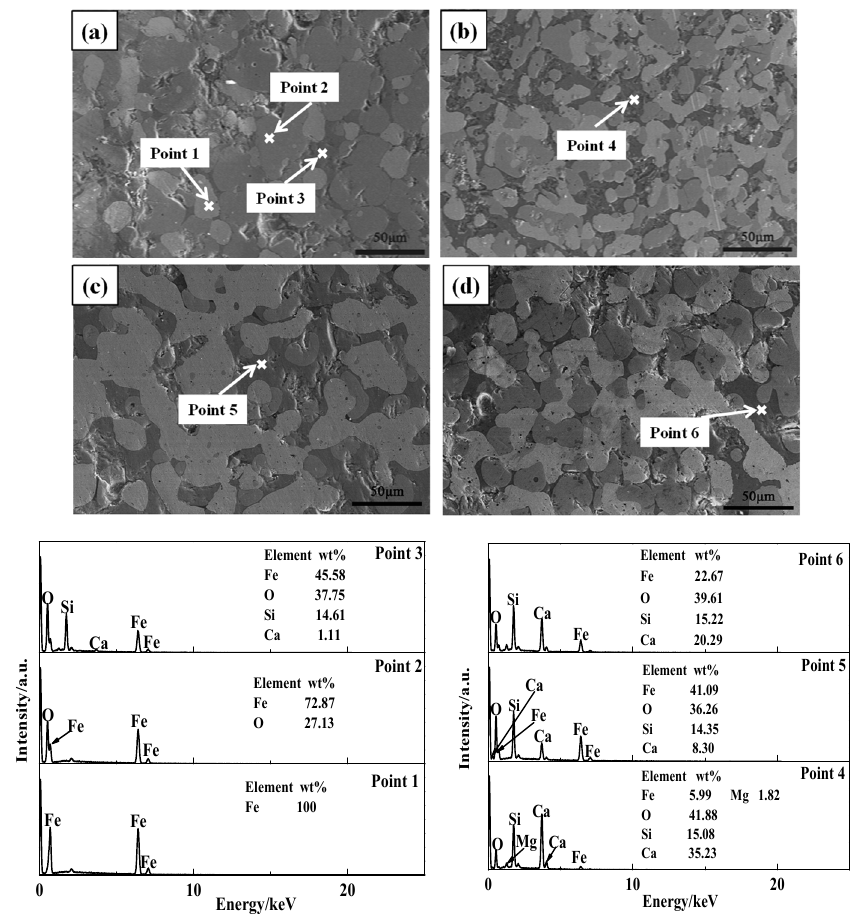
Figure 18. SEM images and EDS analysis of polished pellets at melting temperature with different burden composition: ( a ) PB ( b ) MPB, ( c ) PC, ( d ) MPC.